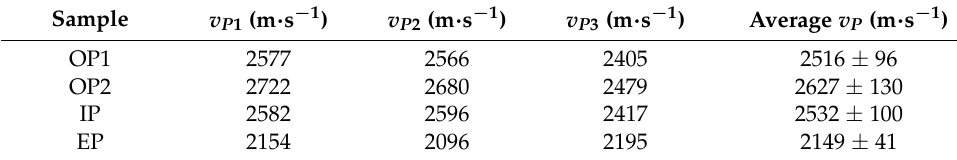
Table 3. Summary of longitudinal wave velocities of the different composite samples.